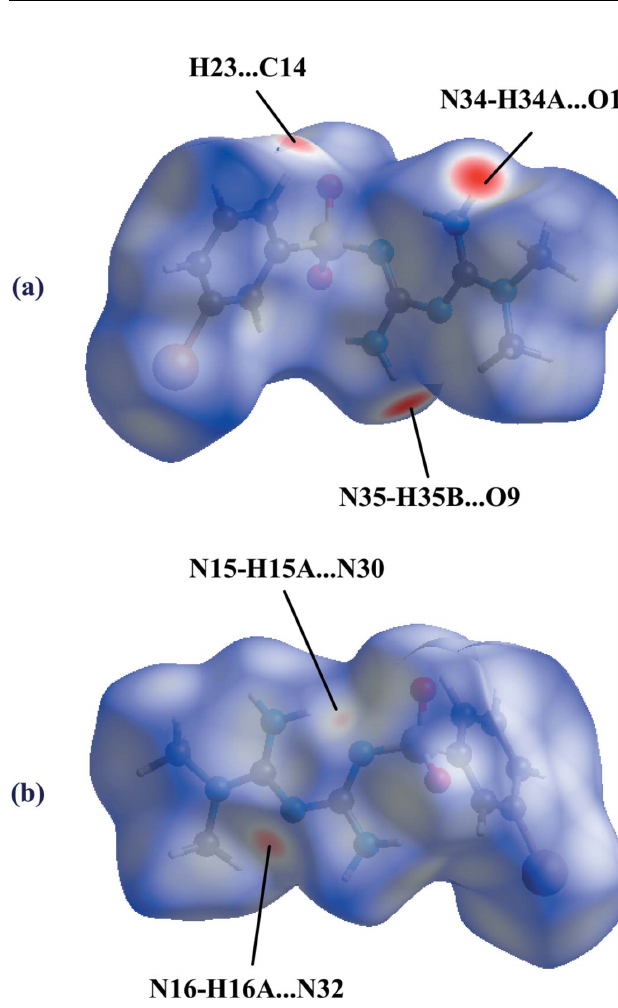
Figure 8 The Hirshfeld surface for molecule B mapped over d norm : ( a ) front view, ( b ) back view.